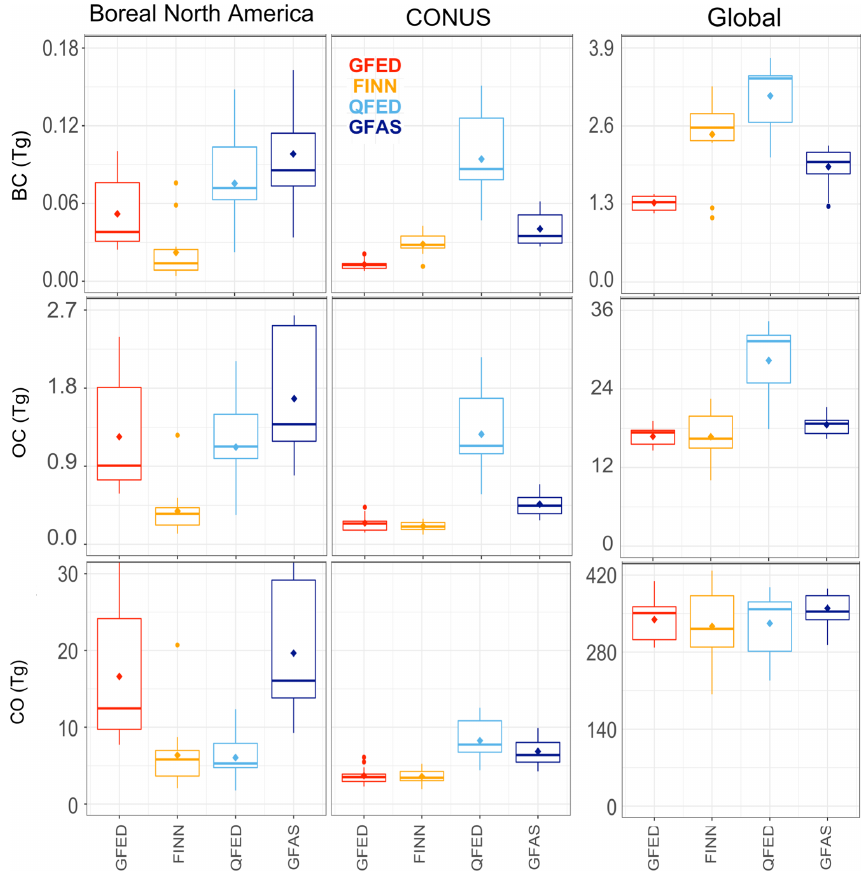
Figure 2. Boxplot summaries of each inventory’s total annual emissions of BC, OC, and CO globally and for boreal North America and CONUS from 2004 to 2016. Diamonds indicate means. The horizontal bar is the median. The box shows the 25th to the 75th percentile, and the whiskers show 1.5 times the interquartile range. Points outside 1.5 times the interquartile range are shown as dots. GFED4s emissions are in red, FINN1.5 emissions are in orange, QFED2.4 emissions are in light blue, and GFAS1.2 emissions are in dark